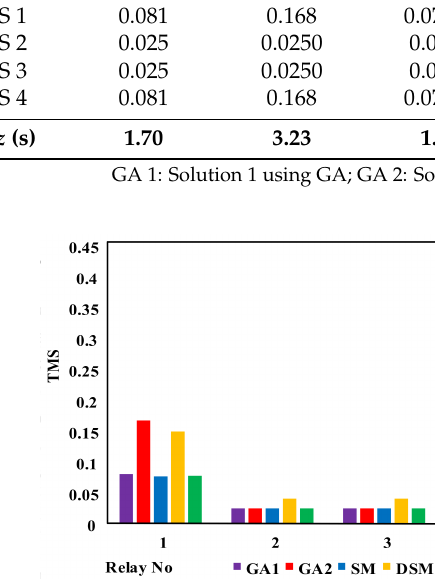
Figure 4. Graphical representation of the optimized TMS compared with the literature for Case I.